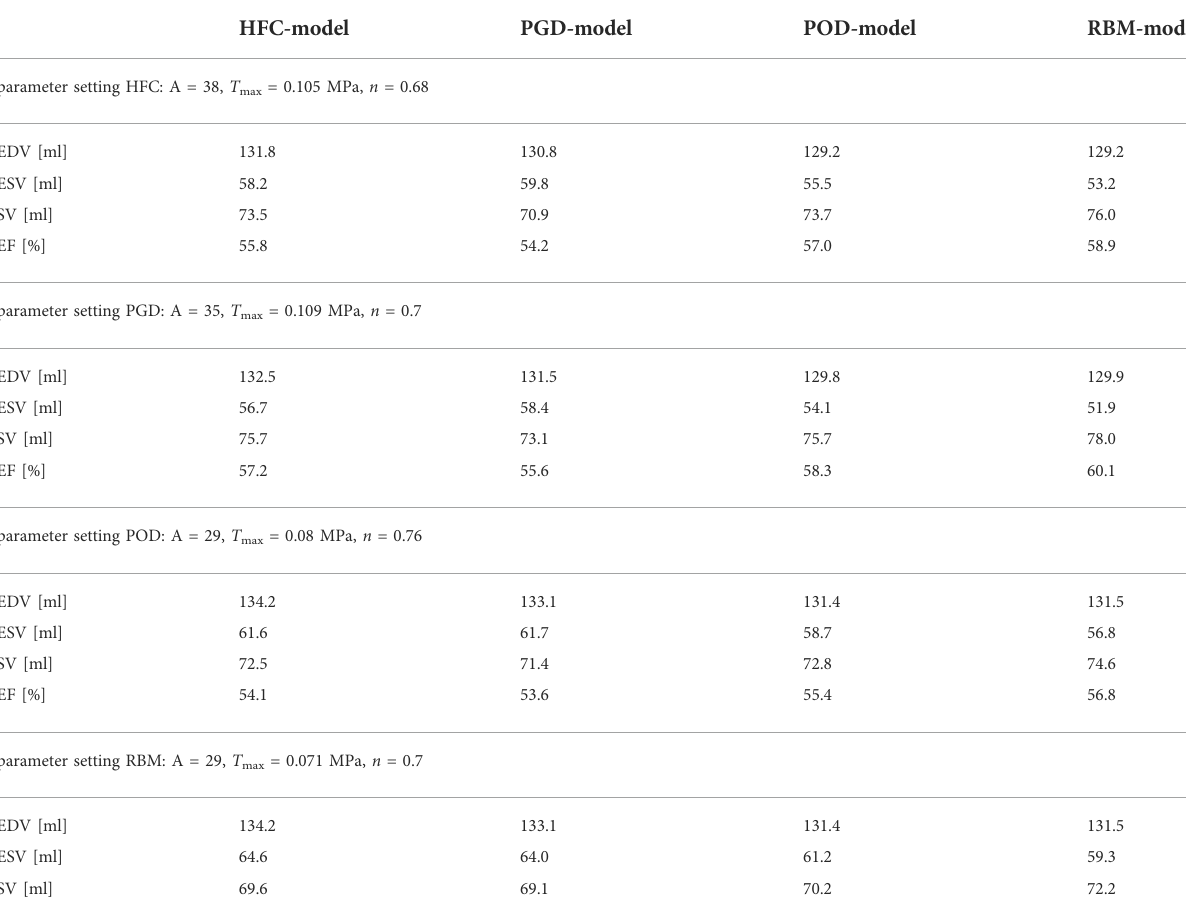
TABLE2Simulatedglobalphysiologicalparameters:minimalend-systolicvolume(ESV),end-diastolicvolume(EDV),strokevolume(SV),andejection fraction (EF). Each was evaluated for all four models: HCF, PGD, POD and RBM obtained from simulations with all four parameter con fi